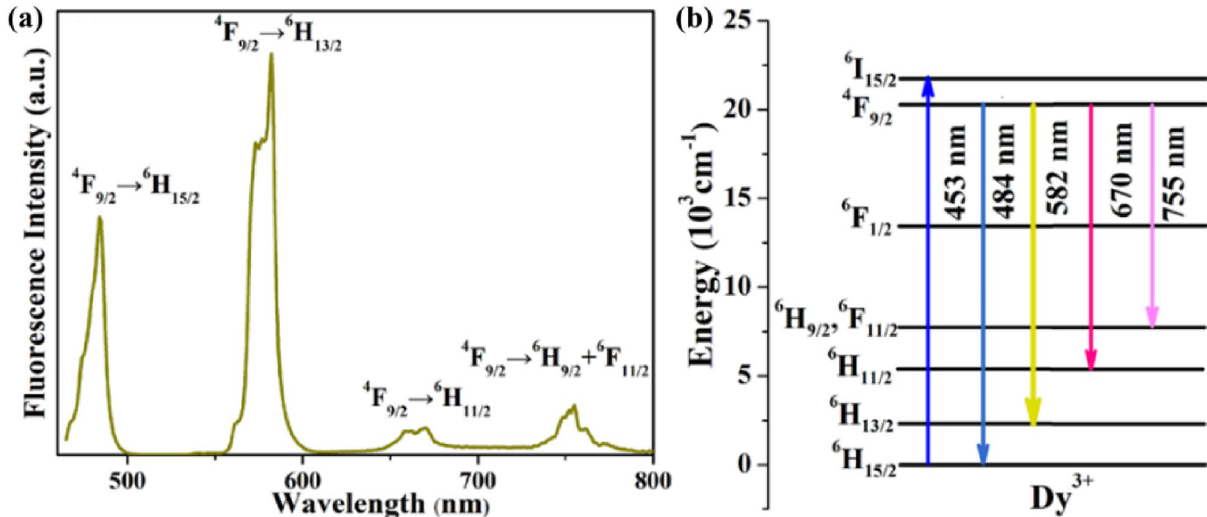
Figure 6. ( a ) The visible emission spectrum of Dy: CYA crystal; ( b ) the diagram of the corresponding energy level